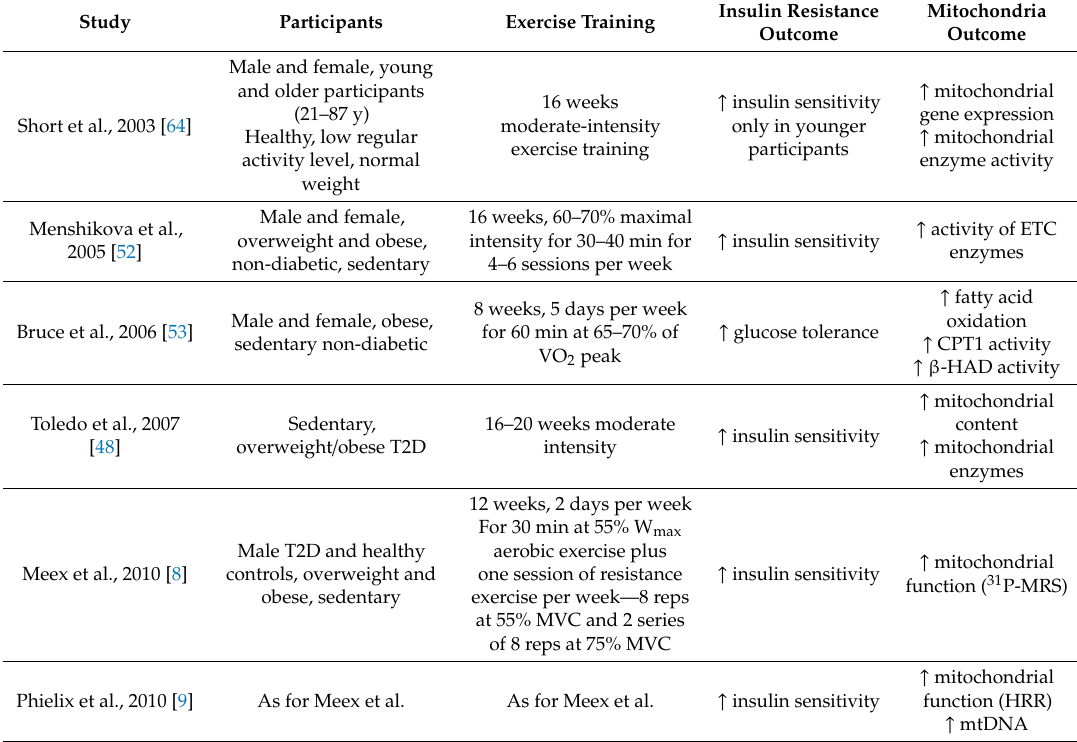
Figure 2. Mitochondrial content in ( A ) fit, healthy people; ( B ) Insulin-resistant people; ( C ) Insulin-resistant people with exercise training. Mitochondrial content tends to correlate with insulin resistance, with good insulin sensitivity in fit, healthy people, and lower mitochondrial content in insulin-resistant people. Both mitochondrial content and insulin sensitivity is improved with exercise training. Glucometer represents the degree of insulin sensitivity, and associated changes in blood glucose concentration. In panel A the glucometer shows blood glucose in the normal range, and fit, healthy people have normal insulin sensitivity. In panel B the glucometer shows the increased blood glucose concentrations present in people with insulin resistance, which are improved with exercise training (panel C). Created with BioRender.com. Table 2. Changes in mitochondrial content and function and insulin resistance with exercise training interventions in individuals who are insulin resistant, obese, and/or have T2D.